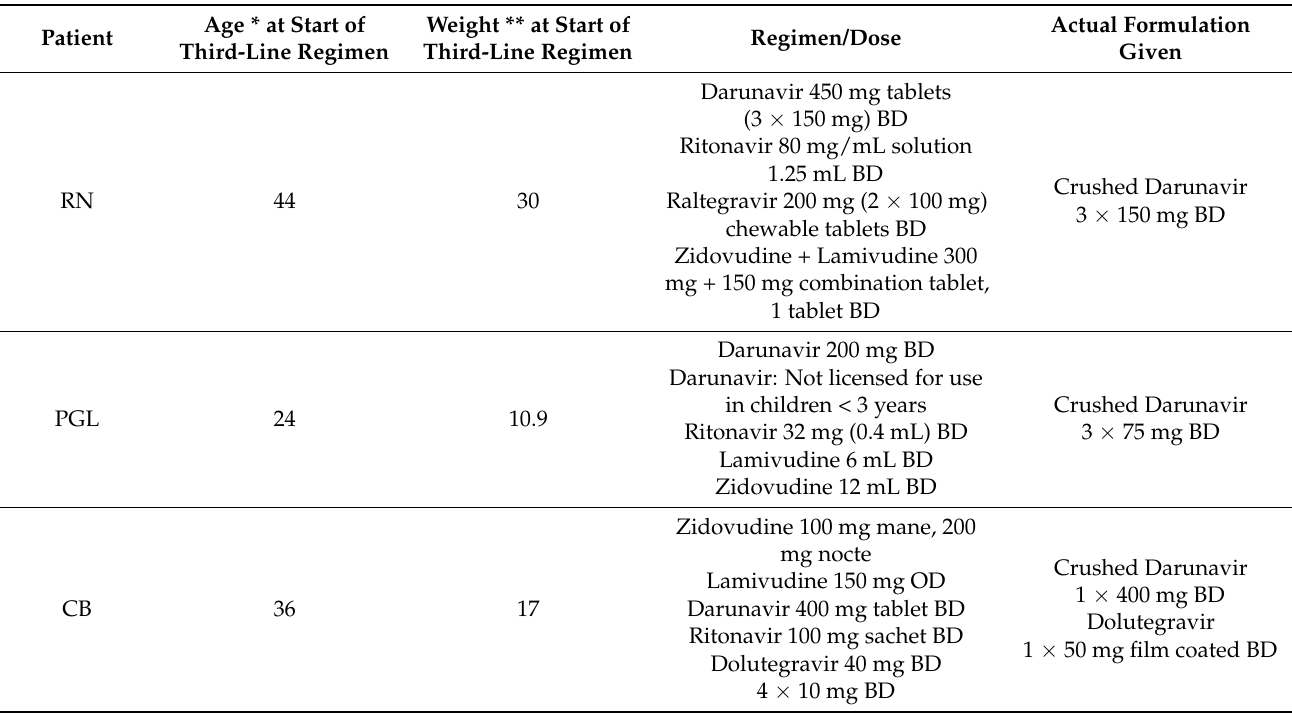
Table 2. Clinical characteristics, third-line regimen and formulations